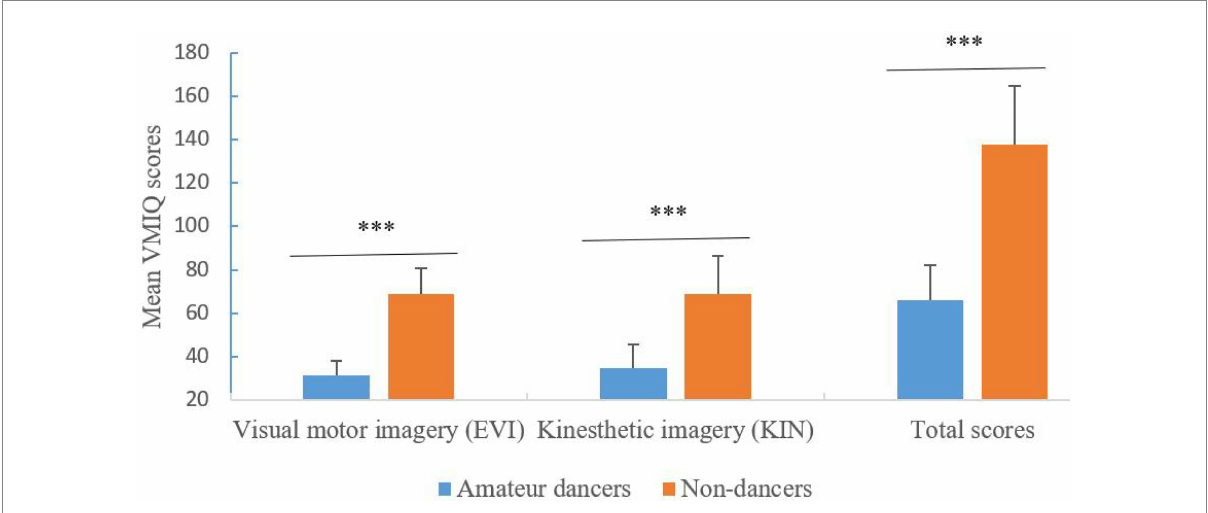
FIGURE 2 Individual differences in mean vividness of motor imagery questionnaire (VMIQ) scores between amateur dances and non-dancers. Asterisks indicate significance of the difference, *** p < 0.001.